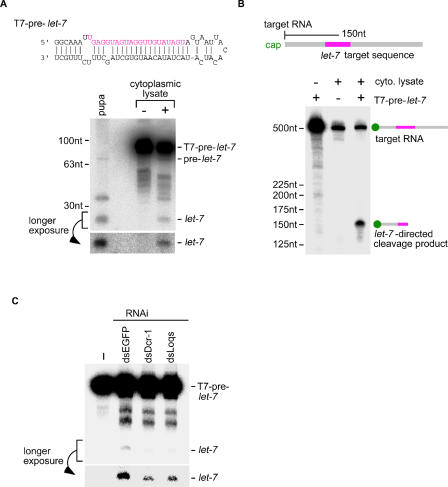
Synthetic D. melanogaster
let-7 Precursor Processing in the Cytoplasmic Lysate of S2 Cells(A) S2 cytoplasmic lysate is capable of processing pre-let-7 into mature let-7. Pre-let-7 (the sequence shown on the top) was transcribed with T7 RNA polymerase in vitro (T7-pre-let-7). After gel purification, it was incubated with S2 cytoplasmic lysate, and resultant RNA was subjected to Northern blotting using an oligodeoxynucleotide recognizing both pre-let-7 and mature let-7. Total RNA prepared from pupa was also applied (pupa), which shows where endogenous pre-let-7 (pre-let-7; ∼70 nucleotides) and mature let-7 (let-7; 21 nucleotides) migrate on the blot. The cytoplasmic lysate (+) lane, but not (−) lane, shows a band corresponding to maturelet-7, meaning that the synthetic T7-pre-let-7 was processed to the matured form in the lysate.(B) Functional analysis of mature let-7 produced from synthetic T7-pre-let-7 in (A). Cap-labeled target RNA with let-7 target site (∼500 nucleotides) was incubated in S2 cytoplasmic lysate with or without T7-pre-let-7 for 3 h.let-7-directed cleavage product (∼150 mucleotides) was observed only when T7-pre-let-7 was included, indicating that let-7 produced in the lysate is functional.(C) Dicer-1- or Loqs-depleted cytoplasmic lysate has less activity to produce mature let-7 from the precursor. Dicer-1 (Dcr-1) or Loqs was depleted from S2 cells by RNAi, and the cytoplasmic lysate was assayed for pre-let-7 processing as in (A). "-" indicates no lysate.